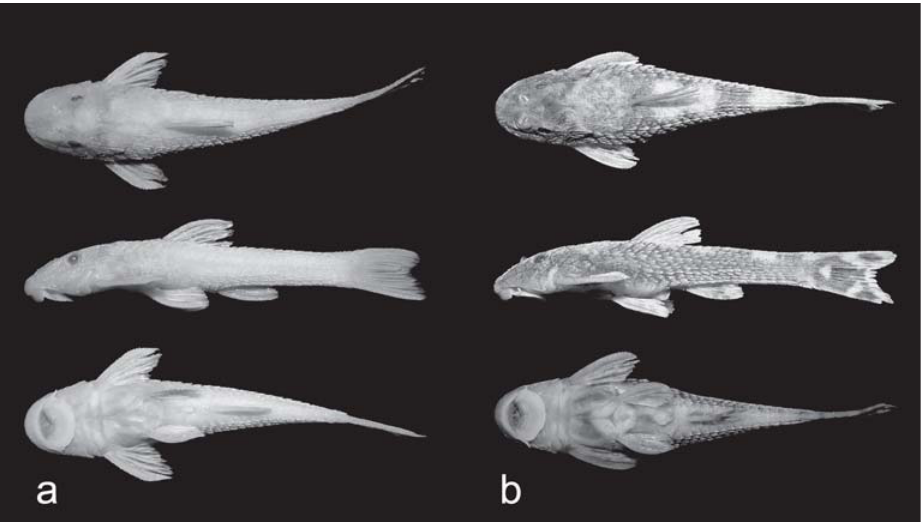
Fig. 1. Schizolecis guntheri , MNRJ 27382, (a) albino specimen, male, 30.11 mm SL; (b) pigmented specimen, female, 30.13 mm SL; Brazil, Rio de Janeiro State, rio Macaé basin, rio